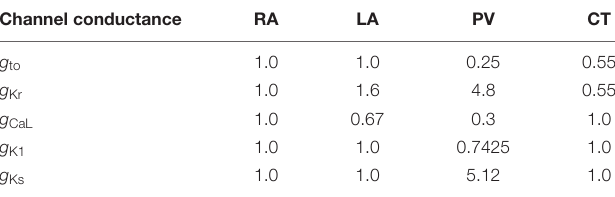
TABLE 1 | Ionic conductance modifications.